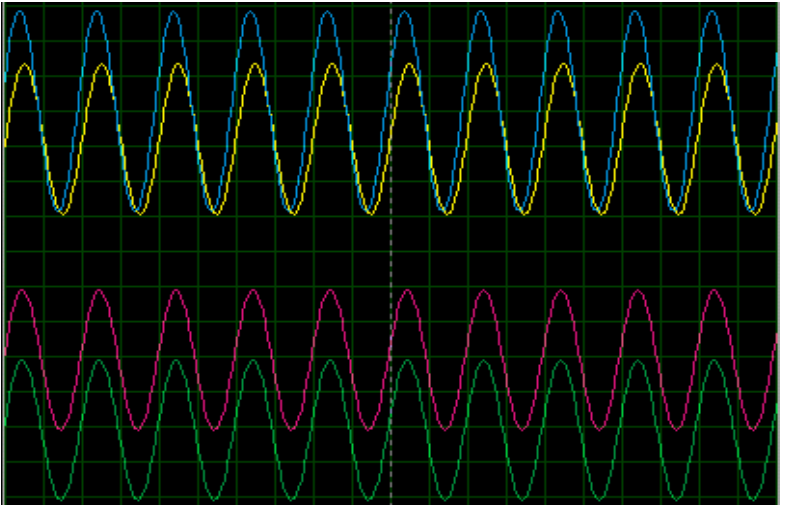
Figure 5. Oscilloscope output from simulation at 25 MHz based on mutual impedance of the two driven elements of Figure 4 (oscilloscope 0.2 V per division) versus high impedance (oscilloscope 0.5 V per division).